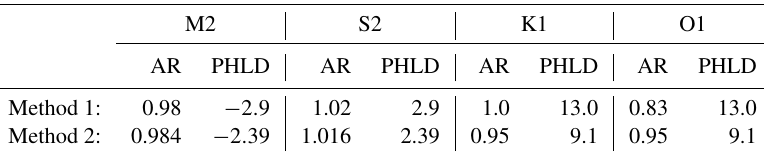
Table 4. Values of ratio of historical to modern amplitudes (AR) and historical phase lag minus modern phase lag (PHLD, ◦ ) obtained in the two methods of Cartwright (1971).